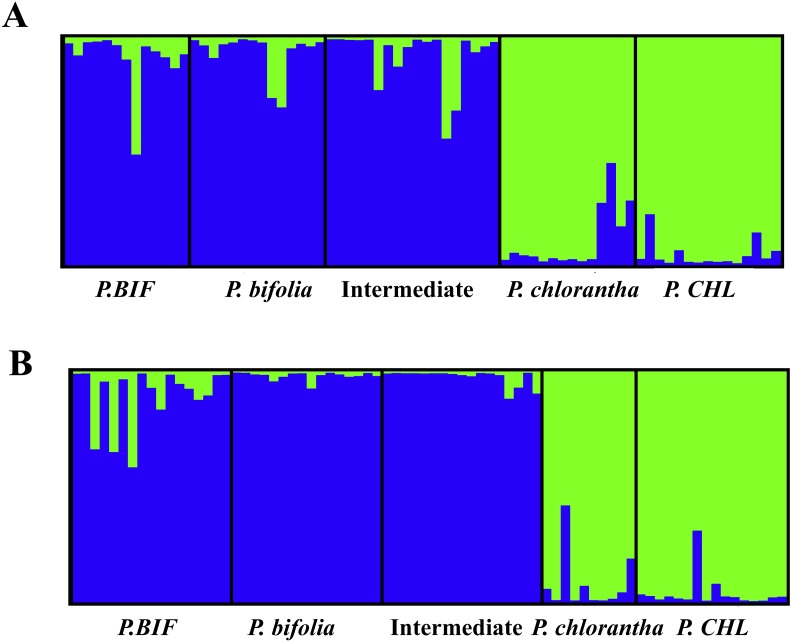
The structure of both sympatric populations inferred by Bayesian clustering is showed using STRUCTURE software (K = 2) with DESTRUCT output.Columns represent individuals, while colours represent the proportion of their genome assigned to each of the two clusters. (A): Botton population + allopatric taxa, (B): Bois Niau population + allopatric taxa. Abbreviations: P. BIF, P. bifolia allopatric and P. CHL, P. chlorantha allopatric.